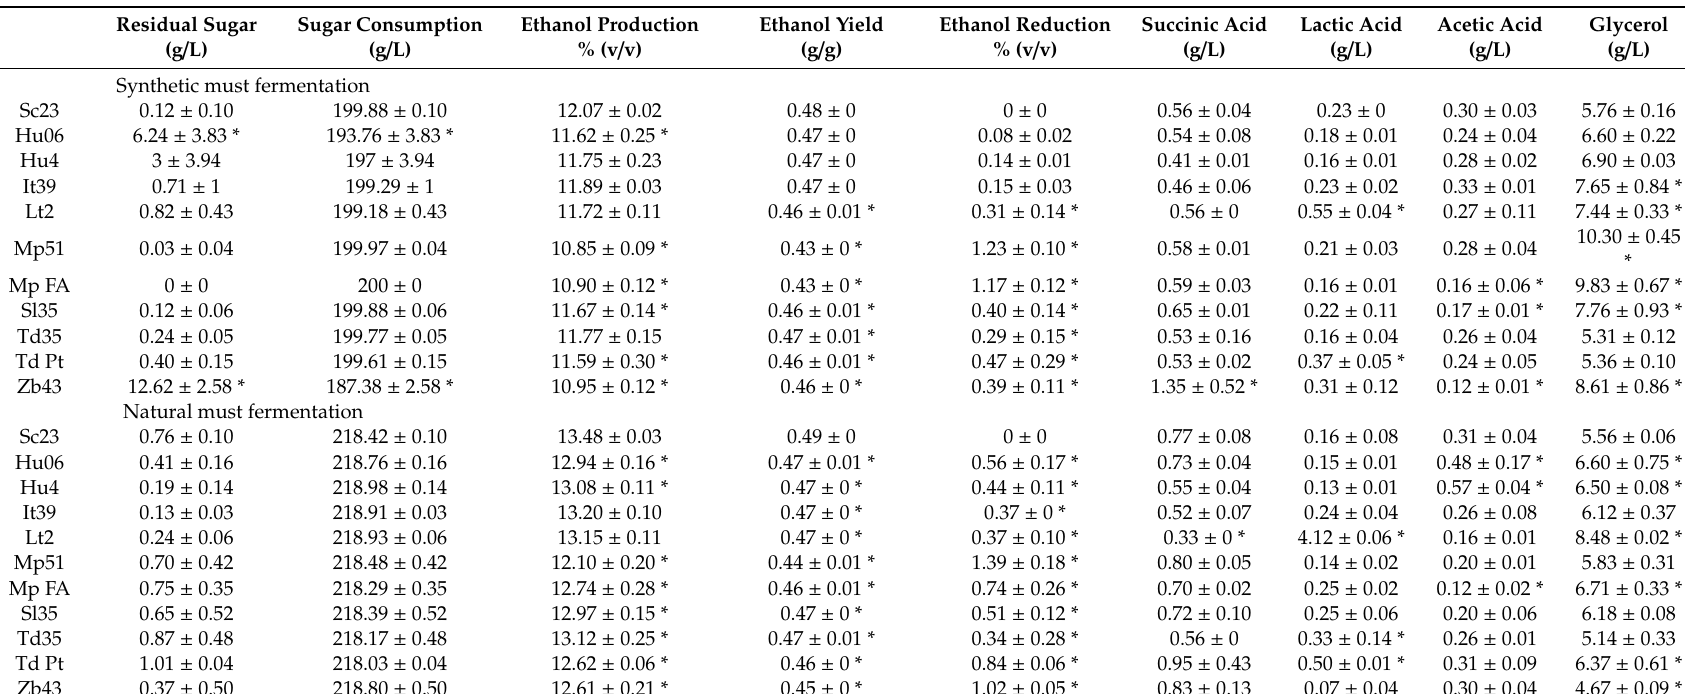
Table 2. Analysis of sugars, ethanol, organic acids, and glycerol from samples at the end of sequential